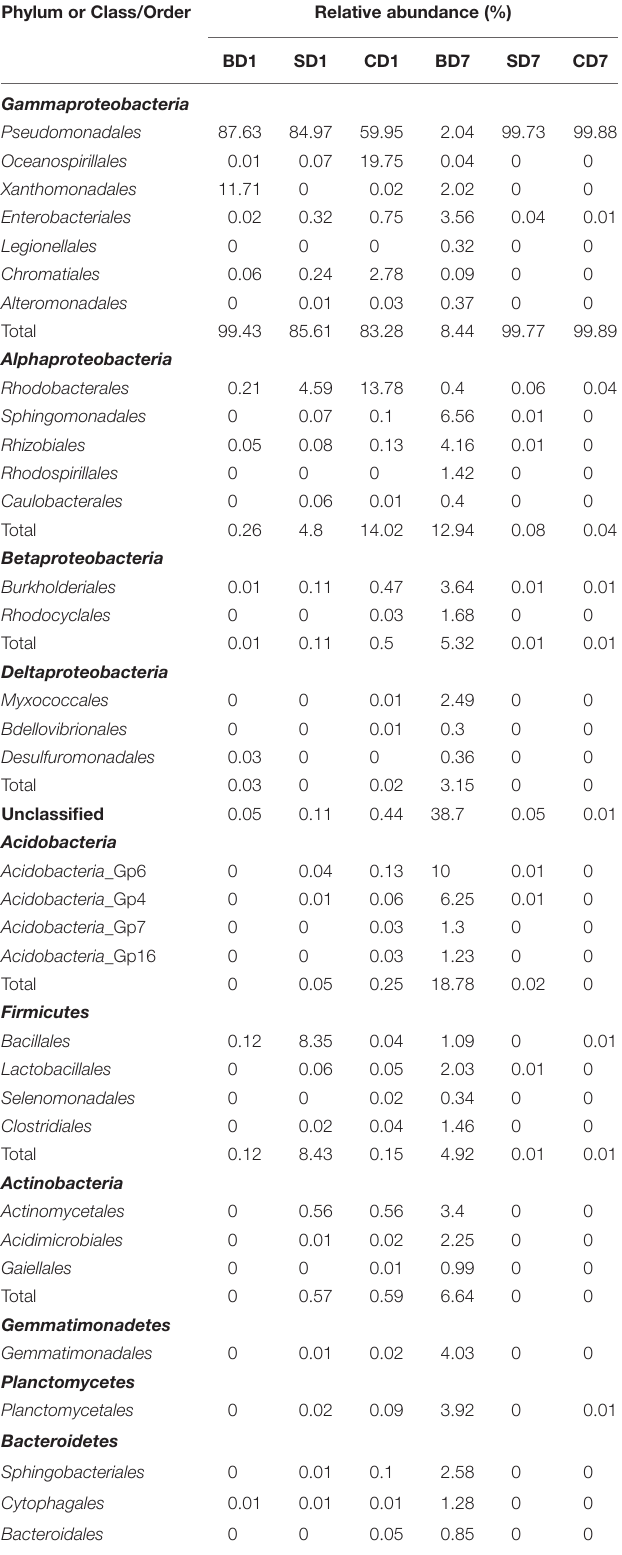
TABLE 6 | Relative abundance of dominant orders in each sample 1